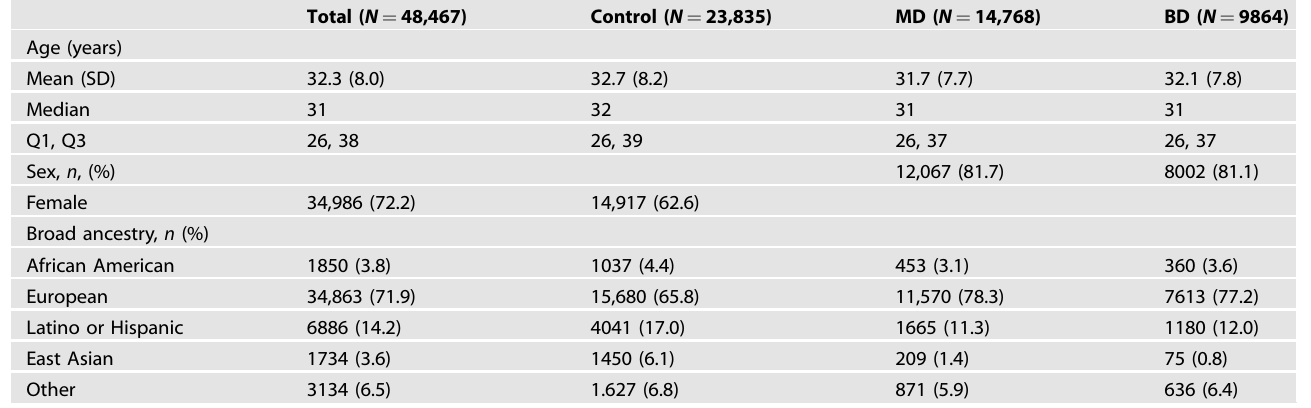
Table 2. Demographics features of all study participants and mood disorder cases and controls seperately.